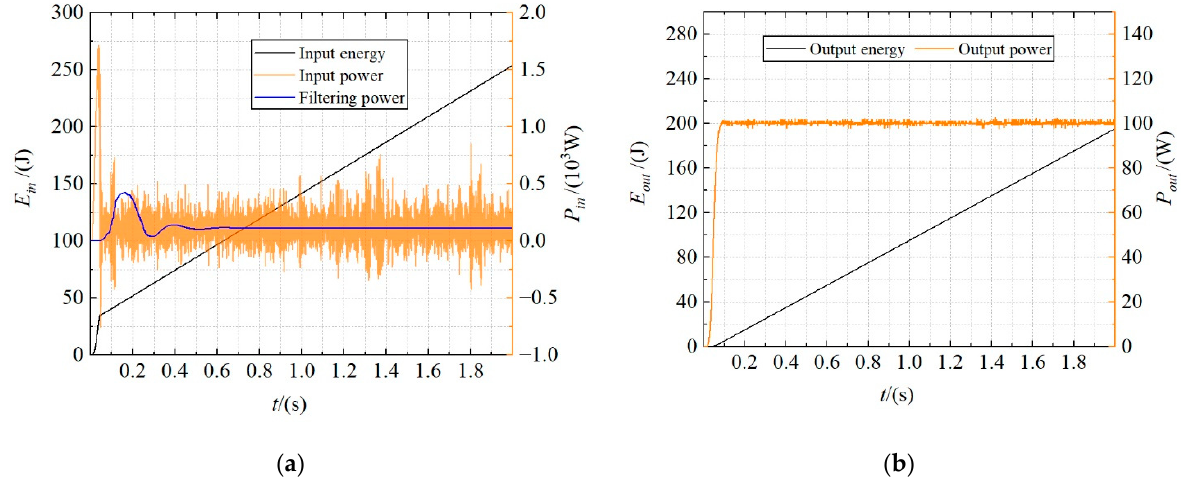
Figure 22. ( a ) The input energy and power of ETD; ( b ) The output energy and power of ETD.